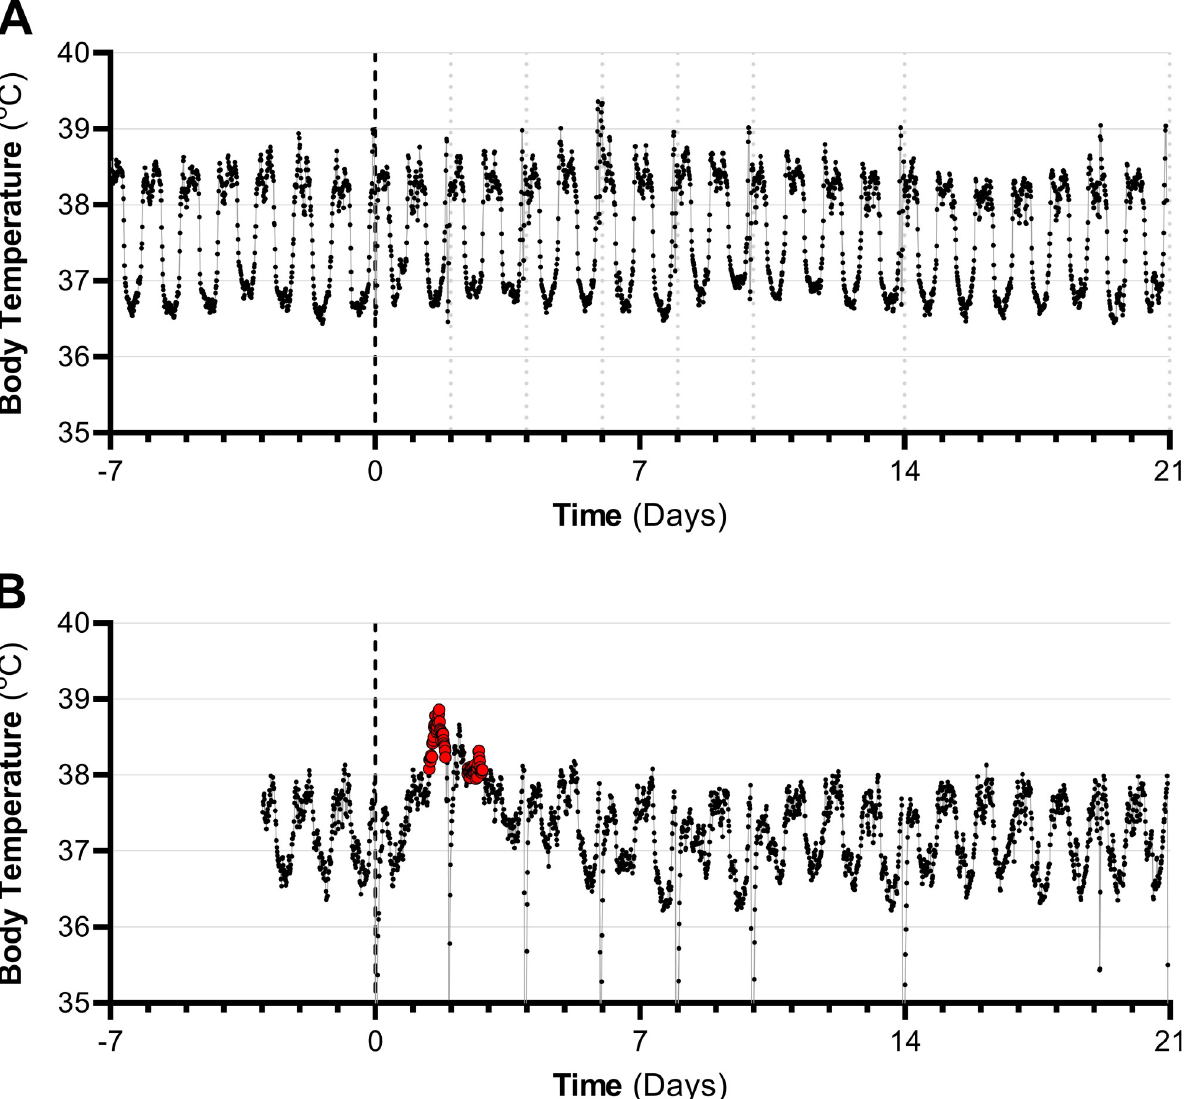
Fig 2. Representative temperature profiles. (A) Temperature profile for animal that received a deposited dose of 58 TCID 50 and did not develop fever, but seroconverted on day 14 post-exposure; (B) Temperature profile for animal which received a deposited dose of 906 TCID 50 that developed fever and seroconverted on day 14 post-exposure. Red circles represent periods of fever in which the body temperature was > 1˚C above baseline for more than two hours. Dark vertical dashed line at day 0 represents exposure. Lighter vertical lines at days 2, 4, 6, 8, 10, 14, and 21 indicate administration of anesthesia for collection of blood and swab samples. Decreases in body temperature are evident upon administration of anesthesia, and disrupt the period of continuous fever observed in the animal shown in (B). samples positive for infectious virus or viral RNA was similar in the group of infected animals with fever (33/140 samples) and the group of infected animals without fever (24/140 samples; P = 0.23 by Fisher’s exact test). However, both were significantly greater than the proportion observed in the group without seroconversion/fever (4/168 samples; P < 0.0001 by Fisher’s exact tests). Levels of infectious virus recovered from swabs ranged from 0.6 to 3.3 log 10 TCID /mL, and were detected as early as two days post-exposure and as late ten days post- 50 exposure. Levels of viral RNA recovered from swabs ranged from 4.3 to 8.7 log RNA copies/ 10 mL, and were detected as early as two days post-exposure and as late as day 21 post-exposure.